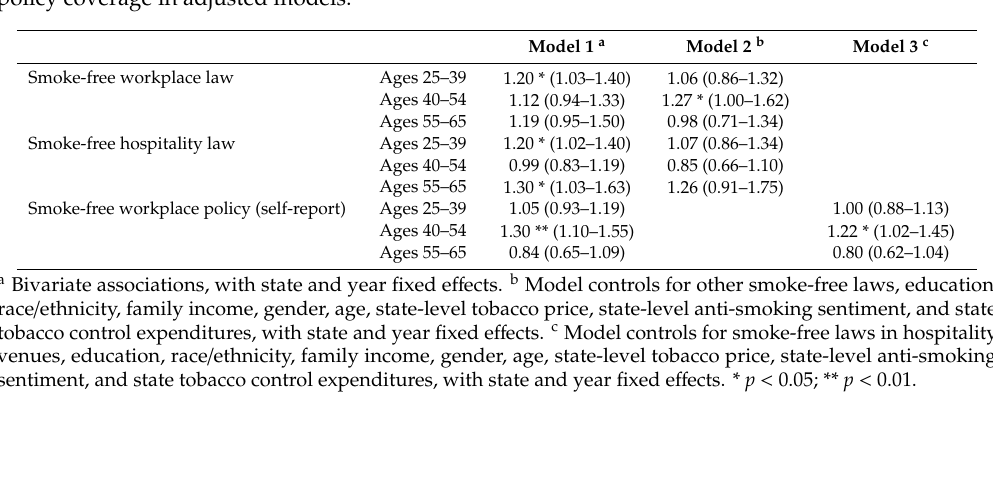
Table 2. Odds ratios for smoking cessation associated with smoke-free laws and self-reported workplace policy coverage in adjusted